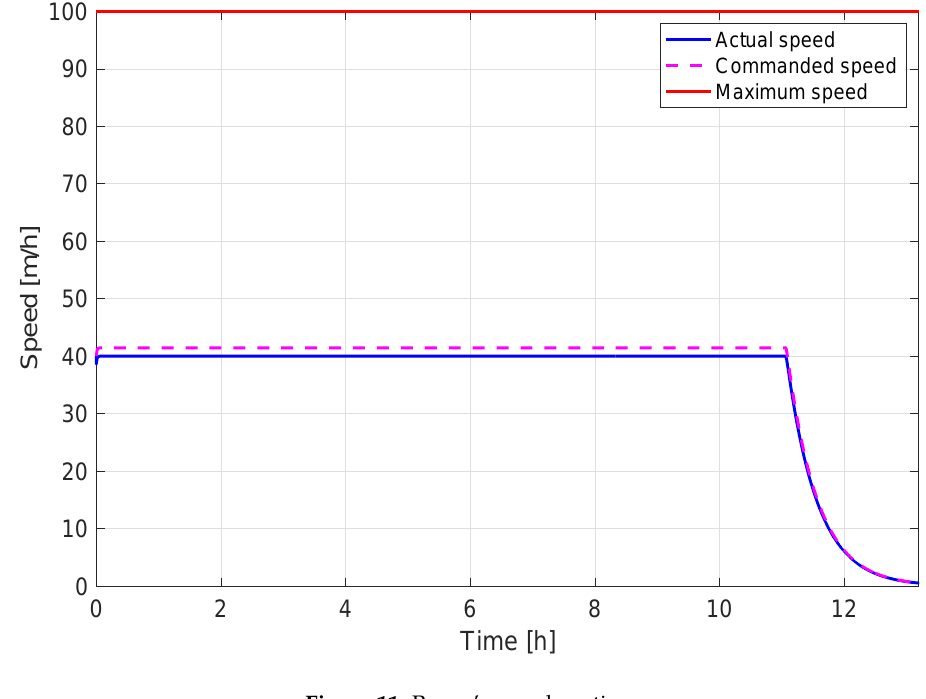
Figure 11. Ro ver’s speed vs . time. Figure 11. Rover’s speed vs. time.